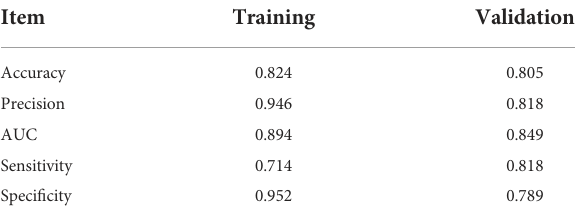
TABLE 3 Evaluation of the RF model in the training and validation samples.